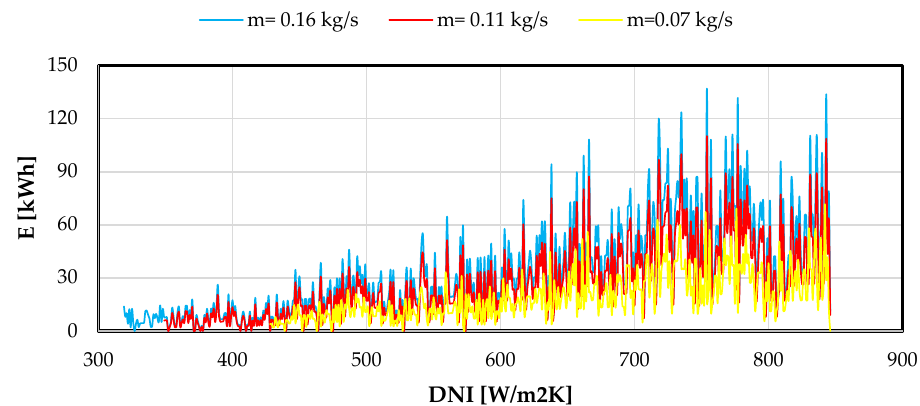
Figure 17. Specific annual power output for each DNI considering three different design mass flow rates.